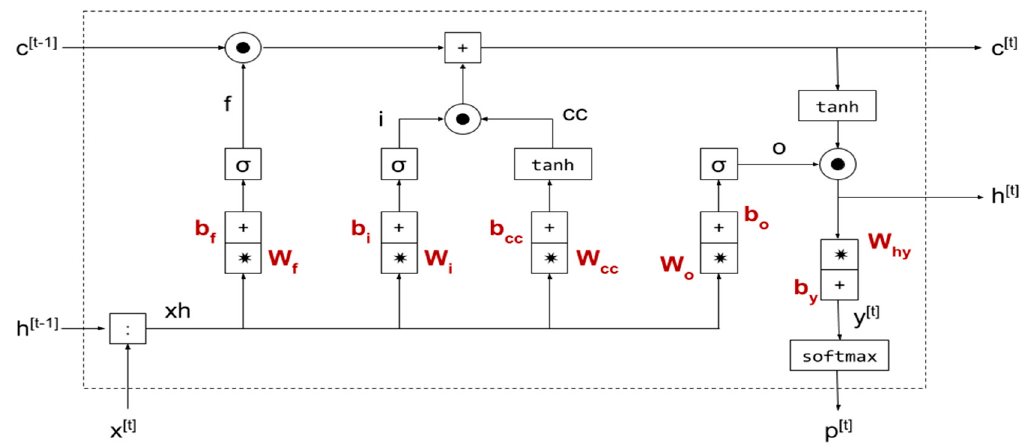
Figure 4. Diagram of the LSTM-GRU model (“*” in the figure is the symbol of multiplication).